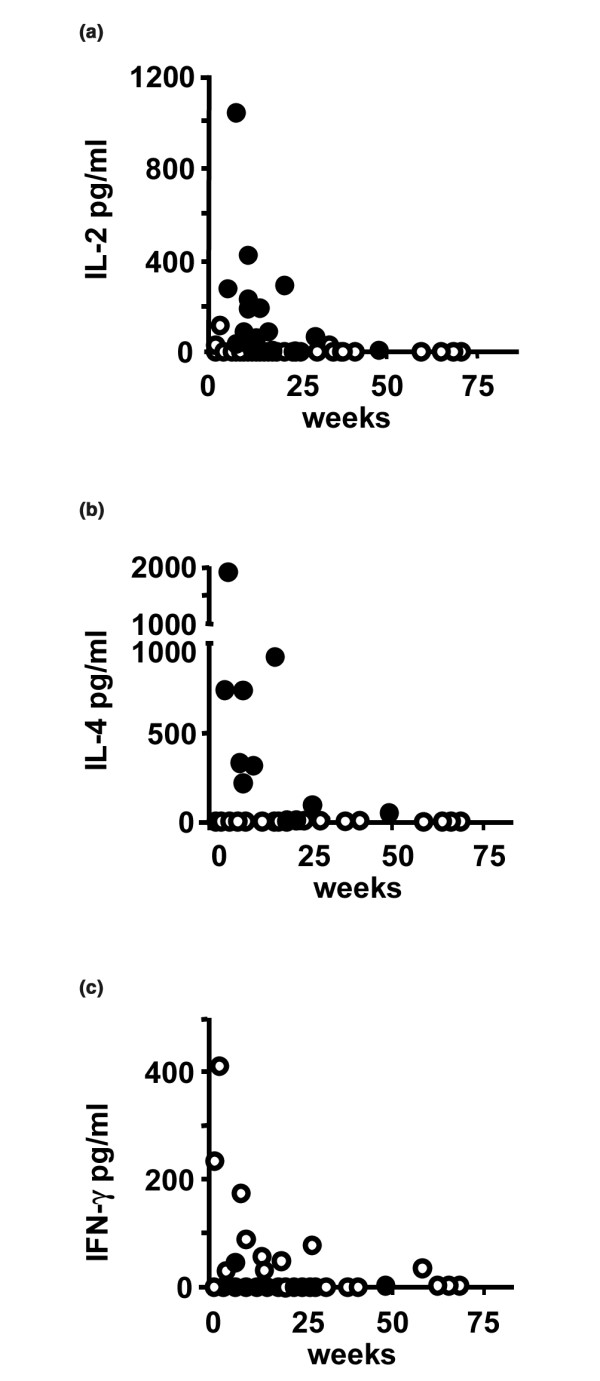
Longitudinal synovial fluid cytokine concentrations (pg/ml) in patients with early inflammatory arthritis. Results are shown for patients with early inflammatory arthritis who develop rheumatoid arthritis (closed circles) and non-rheumatoid persistent inflammatory arthritis (open circles) for (a) IL-2, (b) IL-4 and (c) IFN-γ.